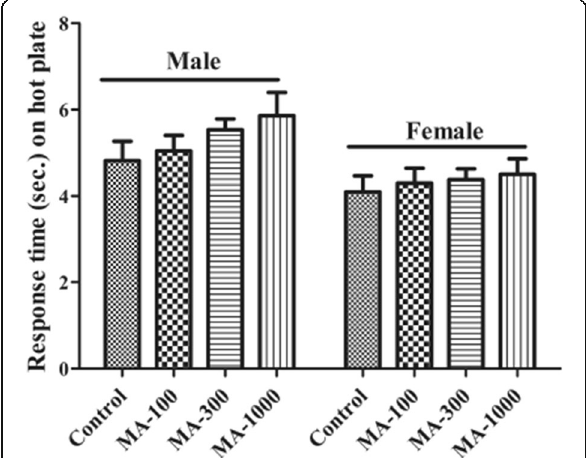
Fig. 4 Response time on hot plate test on male and female rats. Values are mean ± SD, n = 6 animals in each group. P value ( P < 0.05) was considered as statistically significant. Data was analyzed via one way ANOVA followed by Newman-Keuls Multiple Comparison